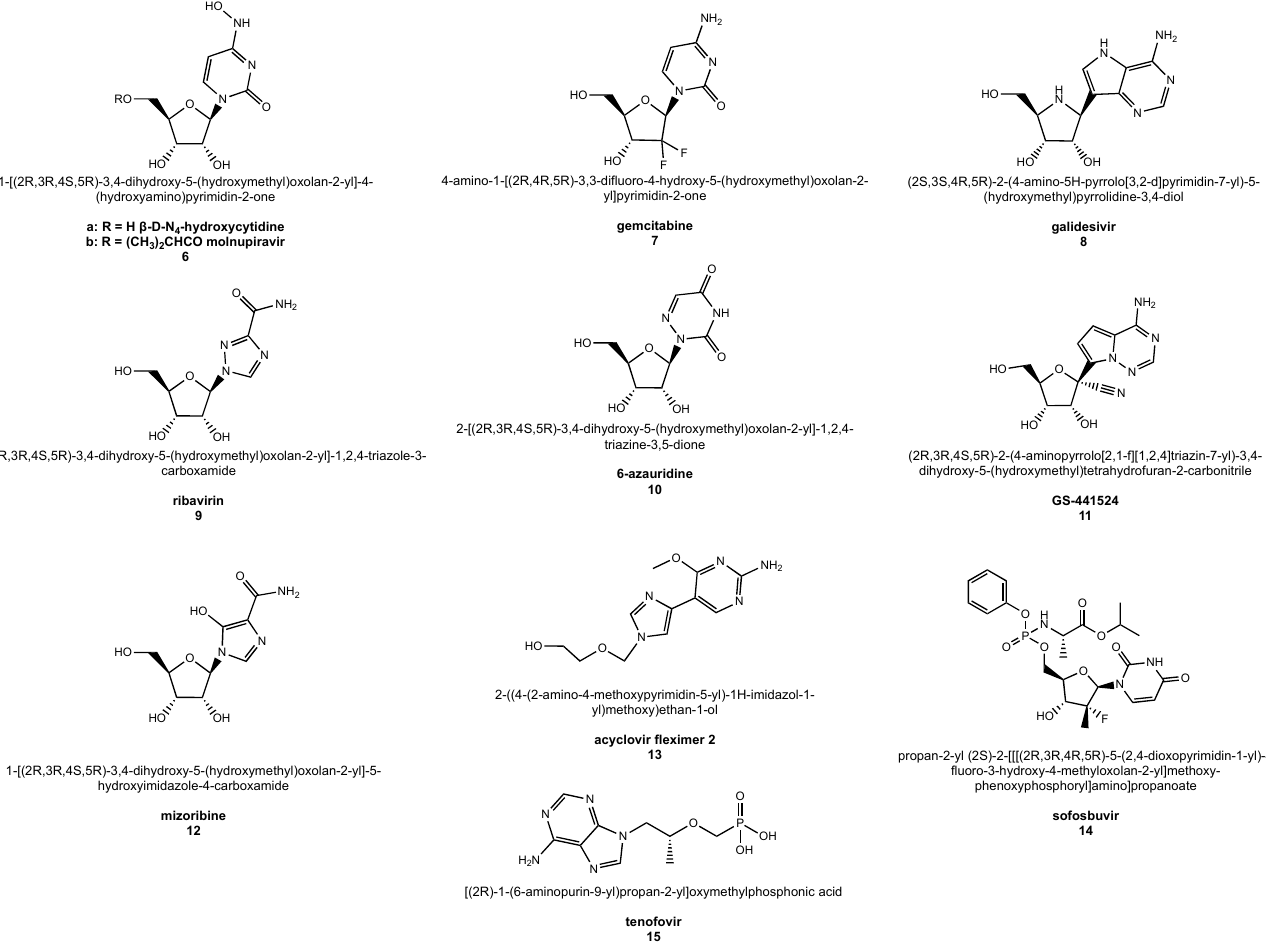
Figure 3. Structures of the nucleoside analogs (provided with drug names and related IUPAC nomenclature) used or under investigation in the HCoV disease therapy.